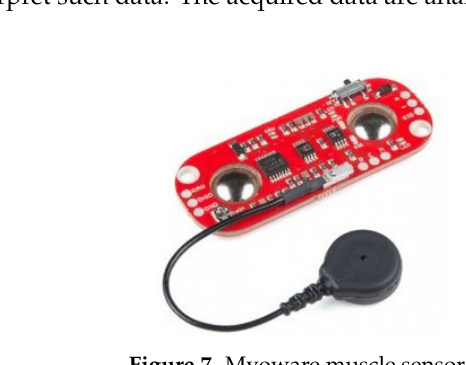
Figure 7. Myoware muscle sensor.